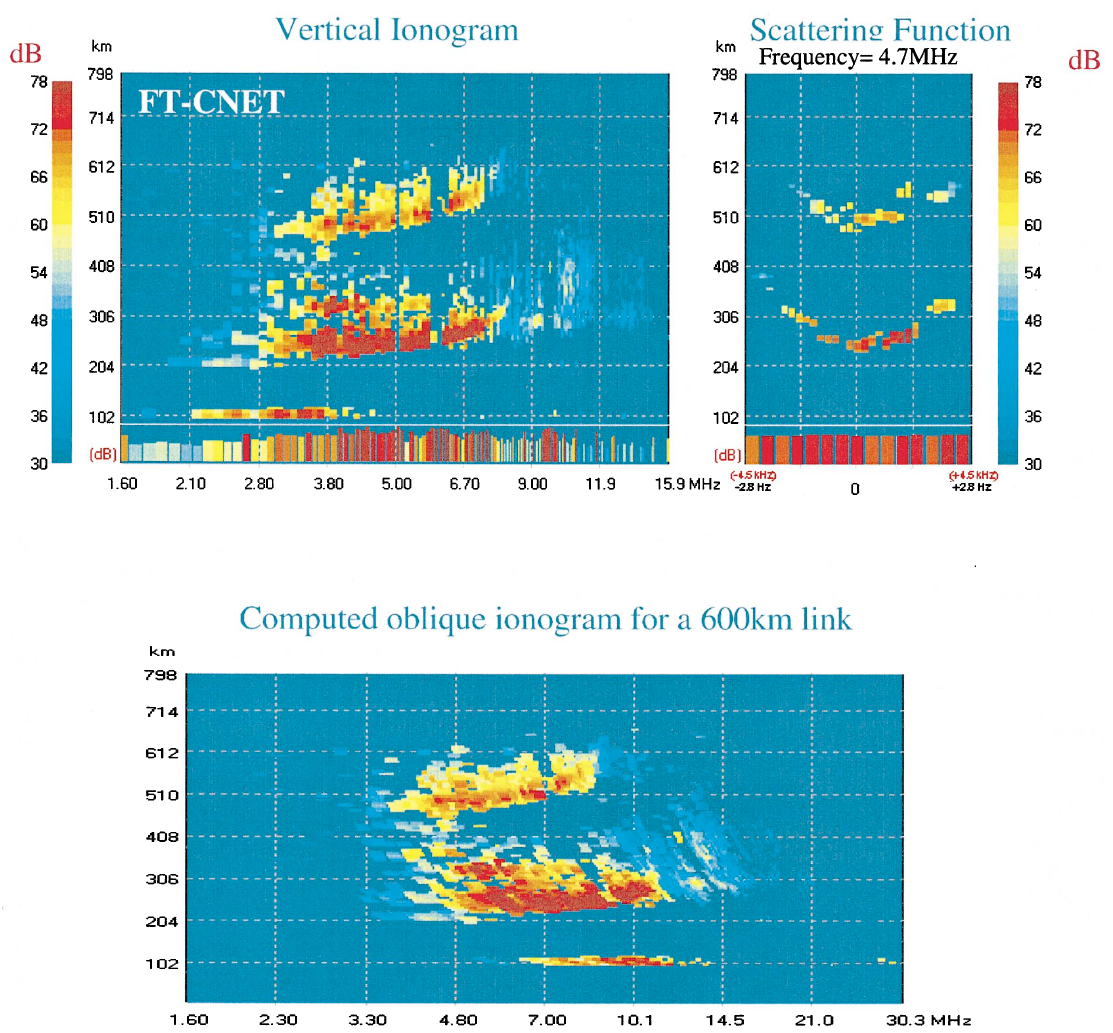
Fig. 2. Experimental results obtained in Dakar on the 18/01/1997 at